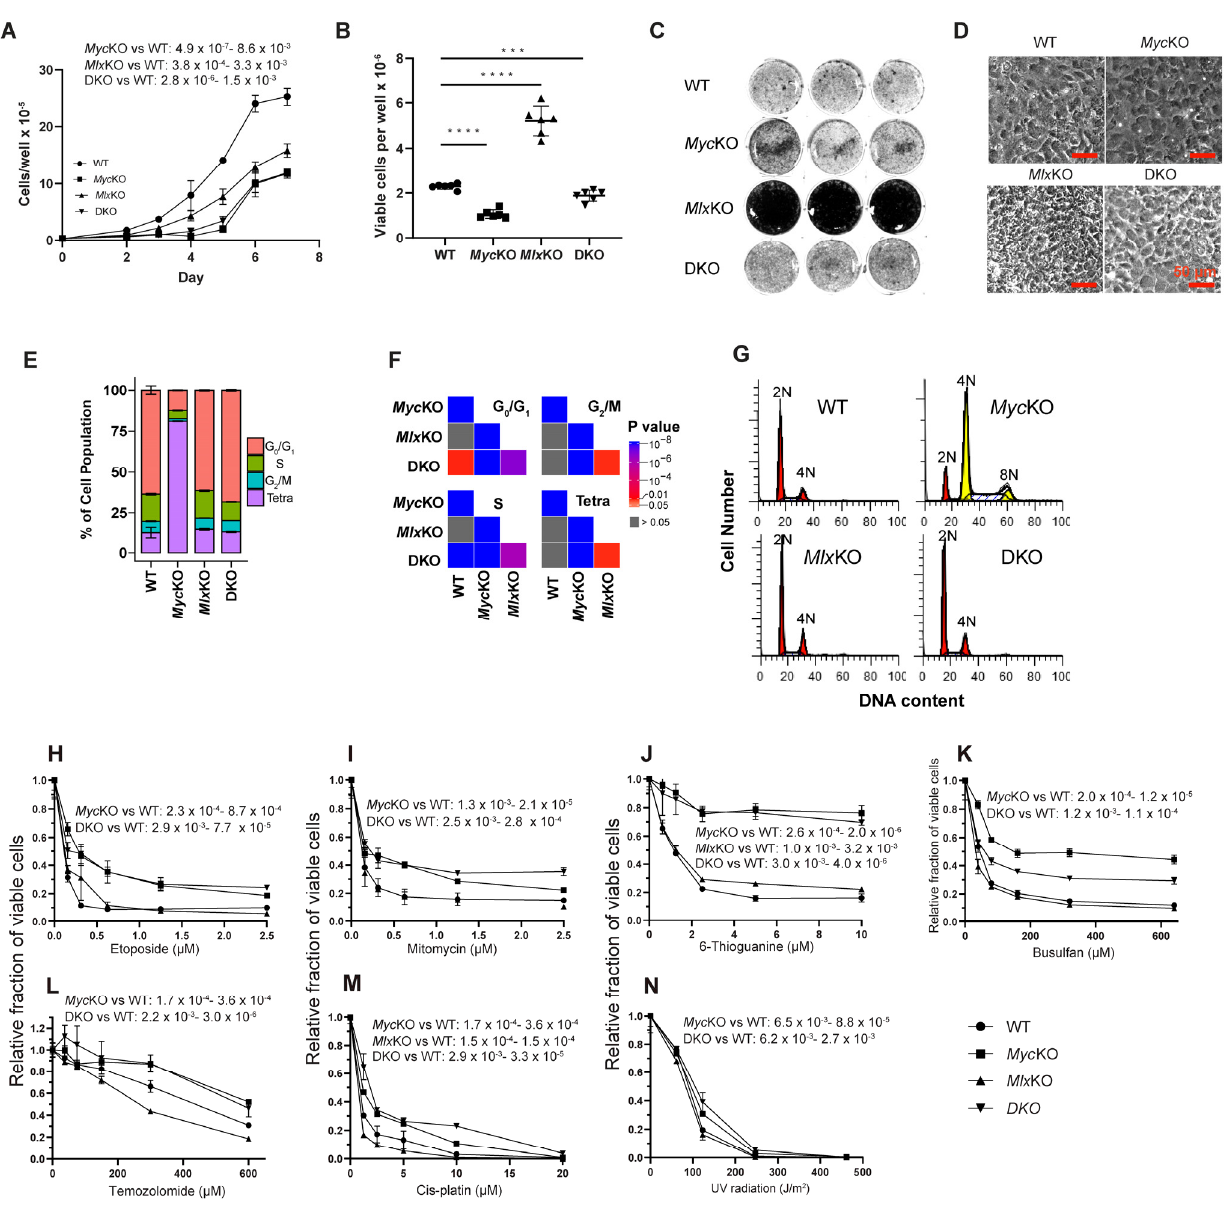
Figure 7. Properties of SV40 T-antigen-immortalized MEFs: ( A ) Growth curves performed as de- scribed in Figure 1E–G. ( B ) Maximum saturation densities attained by the indicated immortalized MEF lines. Logarithmically growing cells were allowed to achieve a confluent state over 2–3 days and were then maintained for an additional 2 weeks, with standard medium changes (10% FBS) being performed twice weekly. Cell counts were performed on six replicates from each group. ( C ) The indicated cells were plated and maintained under confluent conditions for two weeks as de- scribed for ( B ) and then stained with crystal violet. Three replica wells are shown for each group ( D ). Phase-contrast micrographs of typical fields obtained just prior to crystal violet staining of the cells shown in ( C ). ( E ) Cell-cycle analyses performed and analyzed as described in Figure 2A,B. The results shown are the mean values obtained from six independent analyses performed in parallel for each cell line ± 1 S.E. ( F ) Comparison of cell-cycle populations among the four MEF groups, as described in Figure 2B. ( G ) Typical cell-cycle profiles of each MEF cell line showing the presence of tetraploidy/pseudo-tetraploidy in > 80% of Myc KO cells. ( H ) Dose–response curves of the indicated cell lines maintained in the indicated concentrations of etoposide. Cells were plated at densities of